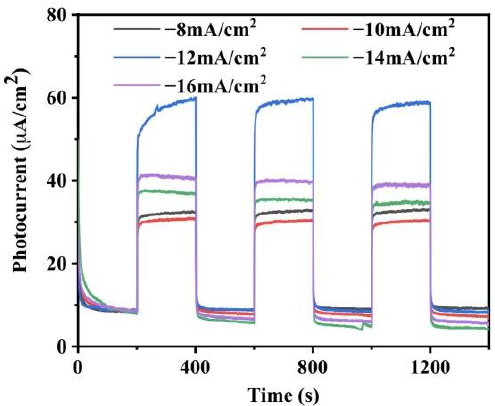
Figure 3. Photocurrent response diagram of WO 3 /TiO 2 /CC materials prepared at different current densities under visible light irradiation.